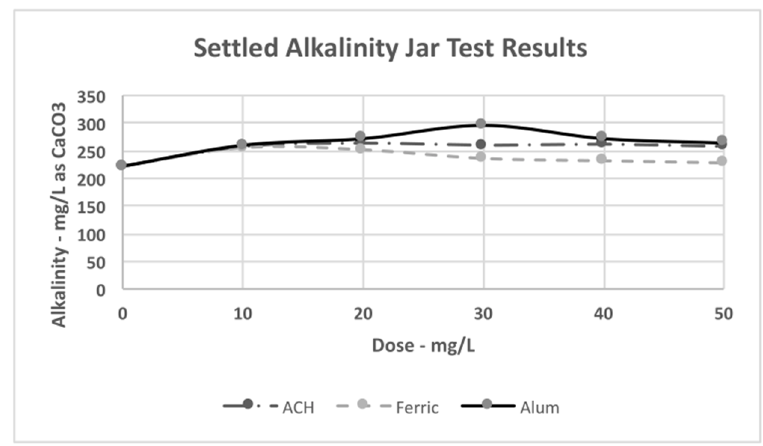
Figure 5. Jar test settled pH versus coagulant dose.